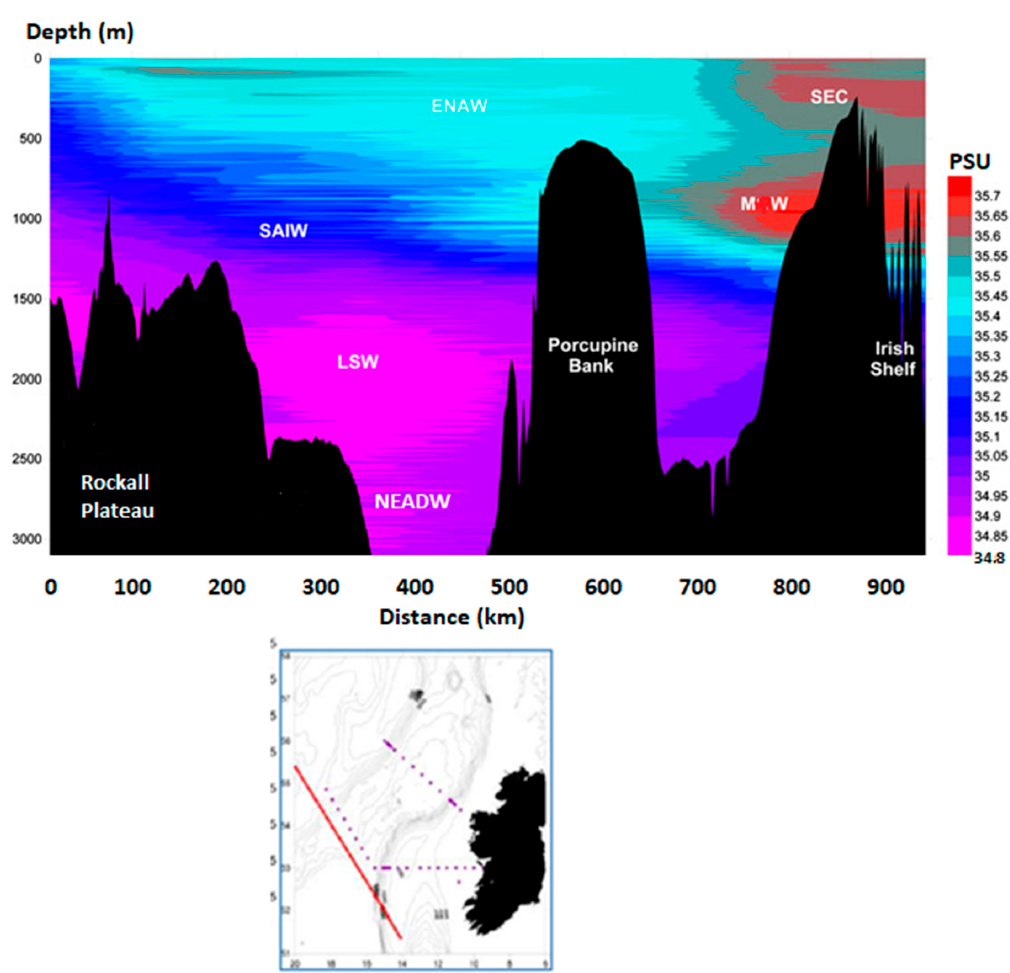
Figure 7. Schematic map of the main water masses across the southern Rockall Trough, adapted from [24,81] with permission of Tomasz Dabrowski & in 2019, where the transect is along the Conductivity Temperature Depth (CTD) points (the purple points are locations of repeat CTD profiles taken as part of an annual ocean climate cruise carried out by the Marine Institute), and the water masses in the plot are ENAW = Eastern North Atlantic Water; SAIW = Subarctic Intermediate Water; MW = Mediterranean Water; LSW = Labrador Sea Water; NEADW = Northeast Atlantic Deep Water; SEC = Shelf Edge Current. This Figure adapted from [24,81] with permission from Tomasz Dabrowski & McGrath in